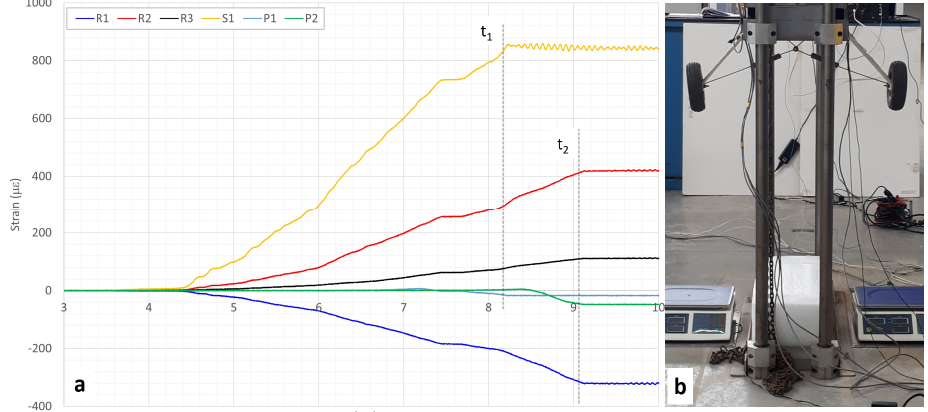
Figure 5. ( a ) Lifting phase: Strain measurements of all the FBGs vs. time, zoomed; ( b ) Rear view of the drop tower, right wheel is higher than the left one.